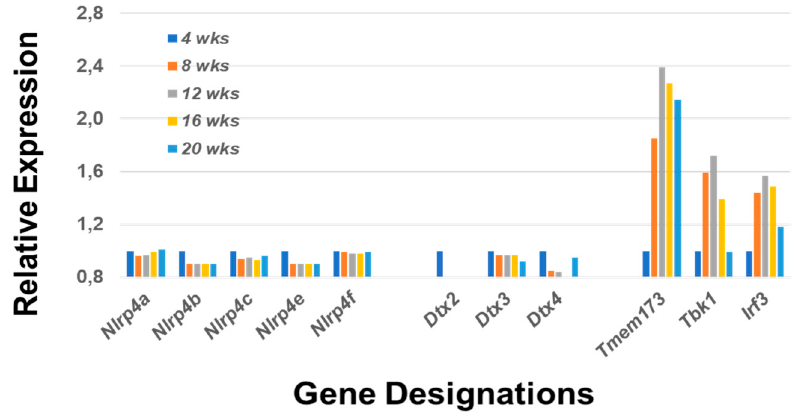
Figure 3. Prolonged upregulated activation of the type 1 IFN response correlates with downregulated Dtx expression. Regulation of type 1 IFN is, in part, dependent on activation of deltex family protein Dtx4 (deltex E3 ubiquitin ligase 4) via Nlrp4 (NLR family, pyrin domain-containing 4). The Nlrp4 complex regulates IFN synthesis by targeting Tbk1 (Tank-binding kinase 1) for degradation by Dtx4. Tbk1 is a critical component in the activation pathway involving Tmem173 (Sting), Tbk1 and Irf3 (interferon regulatory factor 3 ). As neither Dtx4 nor any one of the possible Nlrp4 genes expressed in mice (i.e., Nlrp4a, b, c, e and f ) exhibit temporal upregulated expression, it is predicted that a strong prolonged IFN response would occur in the SS-susceptible C57BL/6.NOD- Aec1Aec2 mice during the disease state giving rise to the IFN signature characteristic of SS.